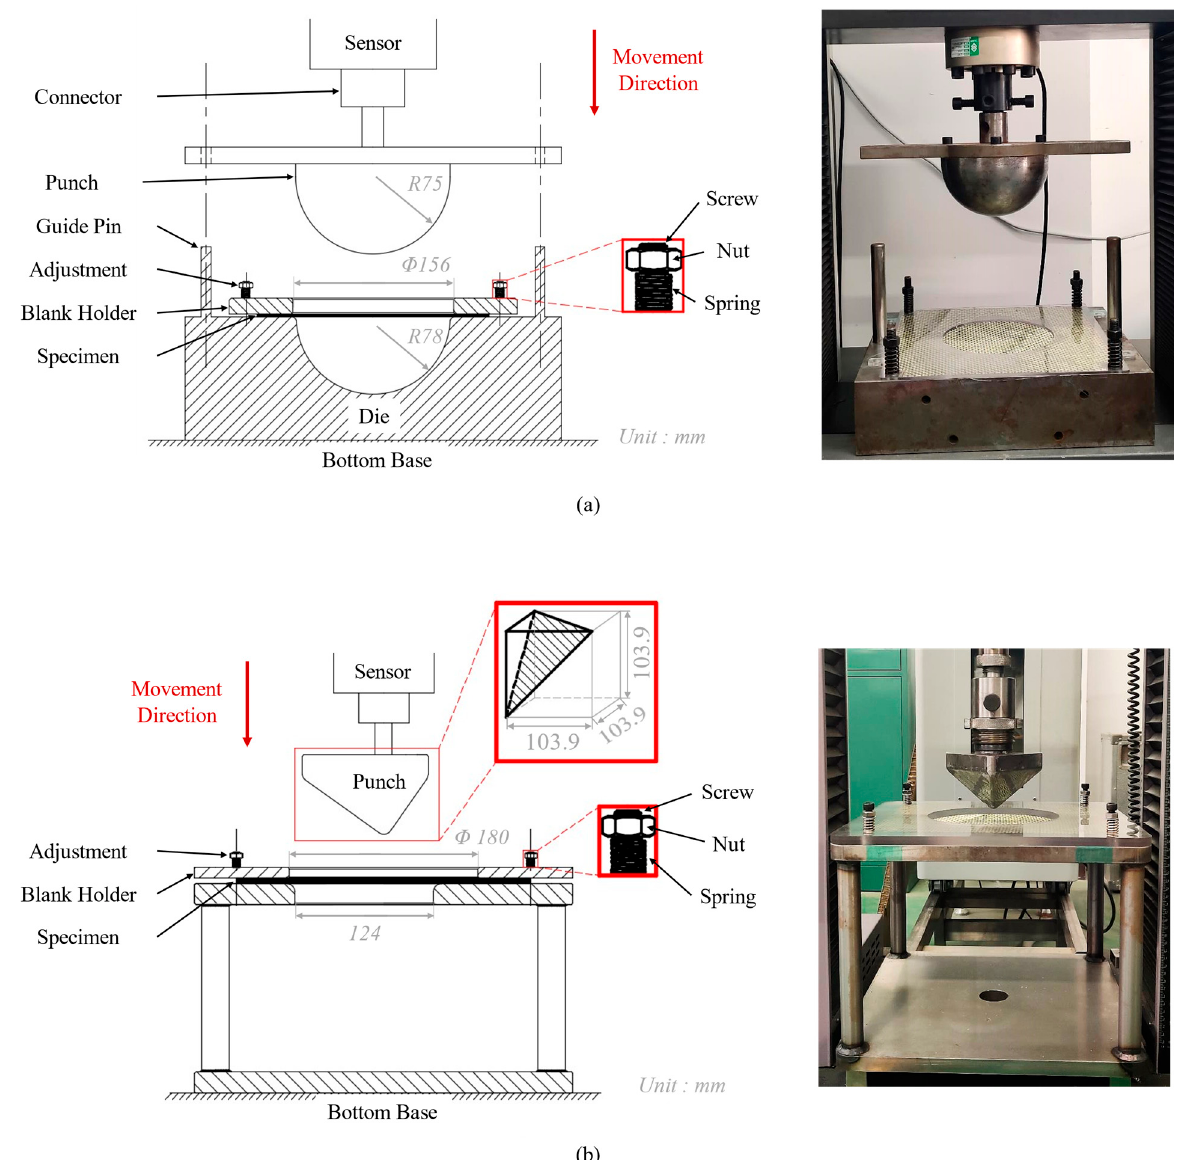
Figure 4. The hemispherical and tetrahedral preforming device: ( a ) experimental set-up for hemispherical preforming; ( b ) experimental set-up for tetrahedral preforming.